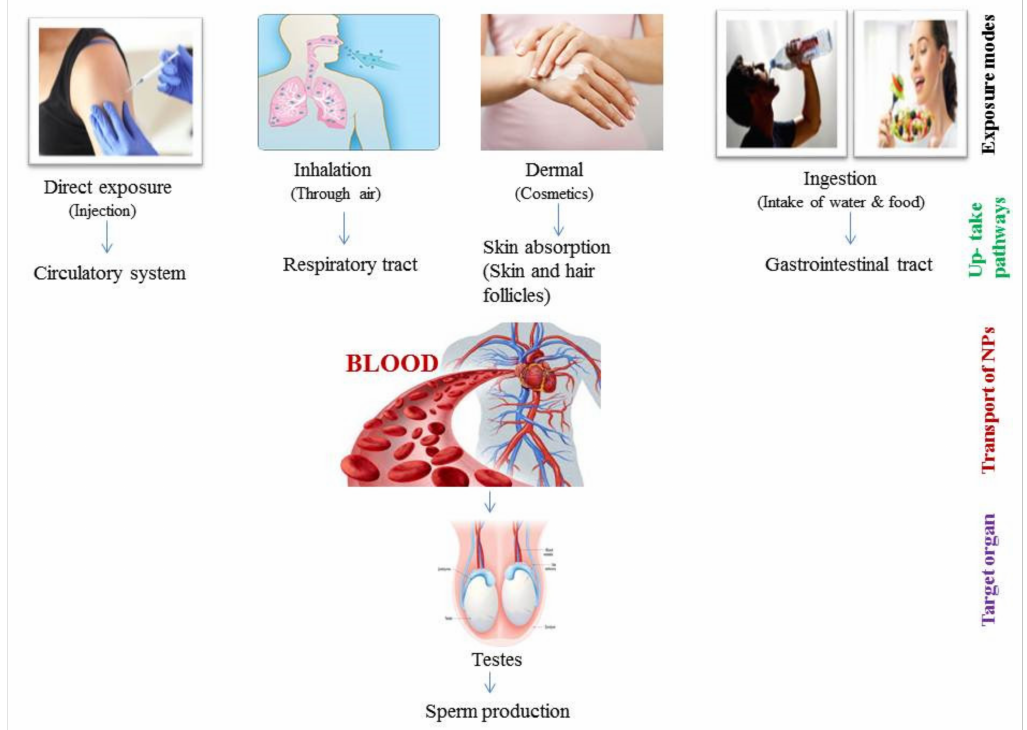
Figure 2. Schematic representation of various routes of nano-particles (NPs) in